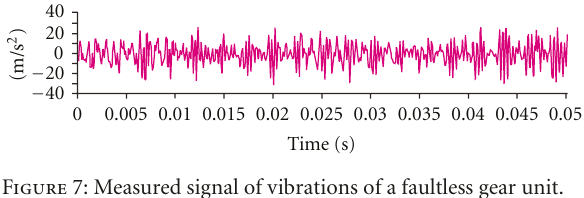
Figure 7: Measured signal of vibrations of a faultless gear unit.